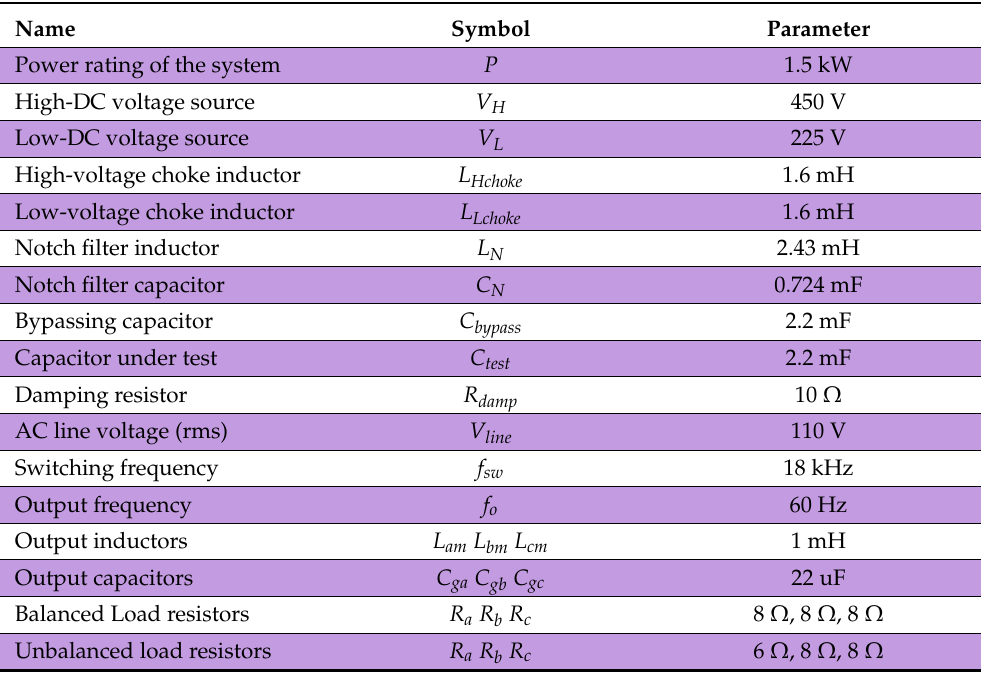
Table 2. Parameters of the down-scale voltage rating evaluation system used in simulation and